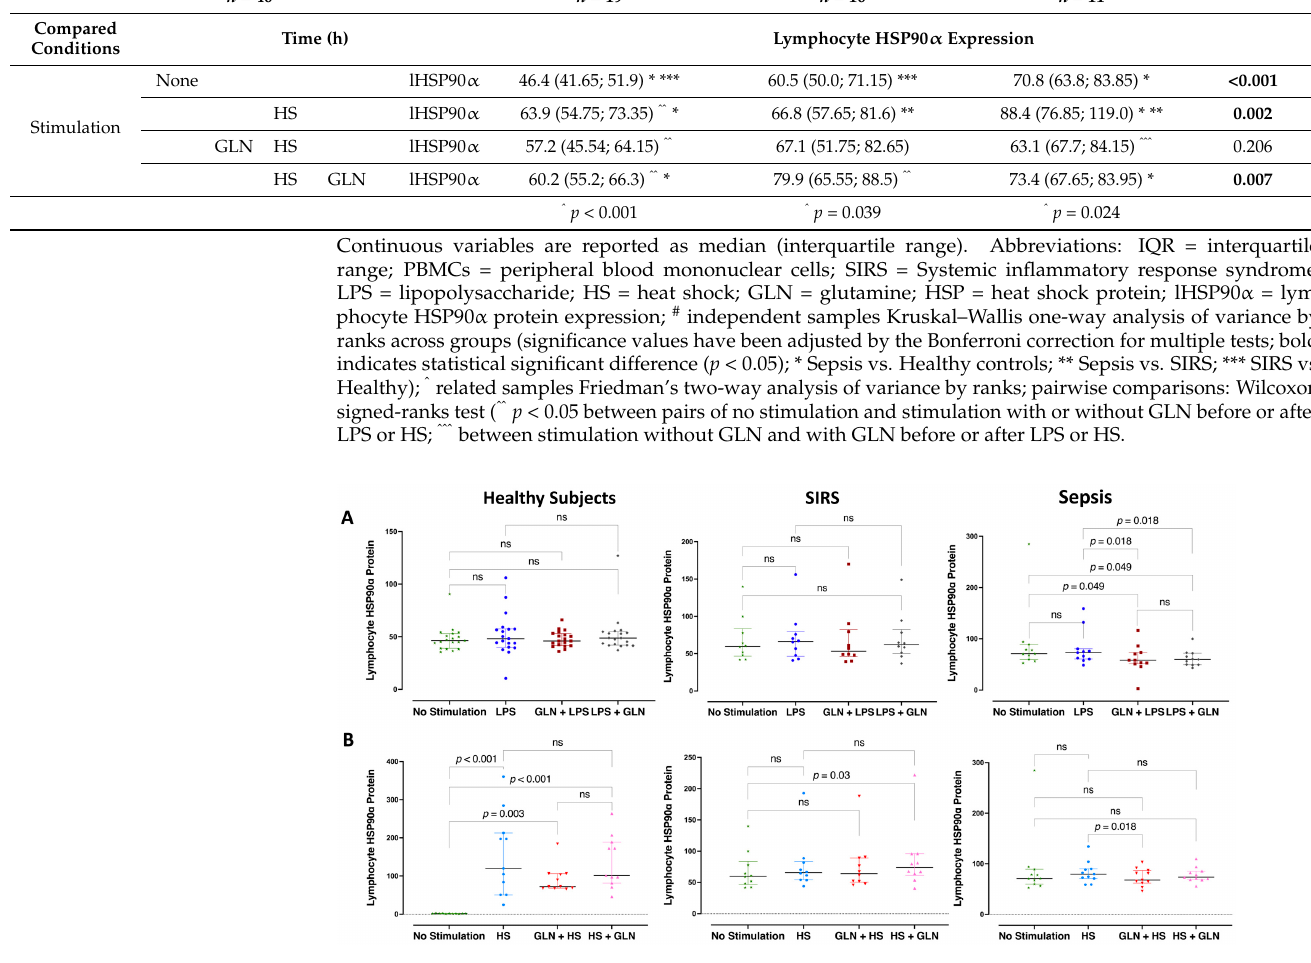
Figure 4. Heat shock protein 90 α expression in lymphocytes (lHSP90 α ) within 4 h of LPS or HS stimulation. Lymphocyte HSP90 α protein expression was increased at baseline in septic and trauma patients compared to healthy subjects ( p < 0.001). ( A ) LPS stimulation did not increase the lymphocyte HSP90 α protein expression in any group. Glutamine before or after LPS decreased the LPS-induced lHSP90 α expression in sepsis. ( B ) HS increased the lHSP90 α expression in the PBMCs in the con- trol group only ( p < 0.001). Glutamine before HS stimulation decreased the HS-induced lHSP90 α expression in sepsis but retained it in healthy subjects and increased it in SIRS when given after HS stimulation. Abbreviations: SIRS = systemic inflammatory response syndrome; HSP = heat shock protein; lHSP90 α = lymphocyte HSP90 α protein; LPS = lipopolysaccharide; HS = heat shock; ns = not significant. Each dot represents an individual patient; dots of different colors represent different stimulant situations as indicated in axis labels; lines represent medians and bars interquartile